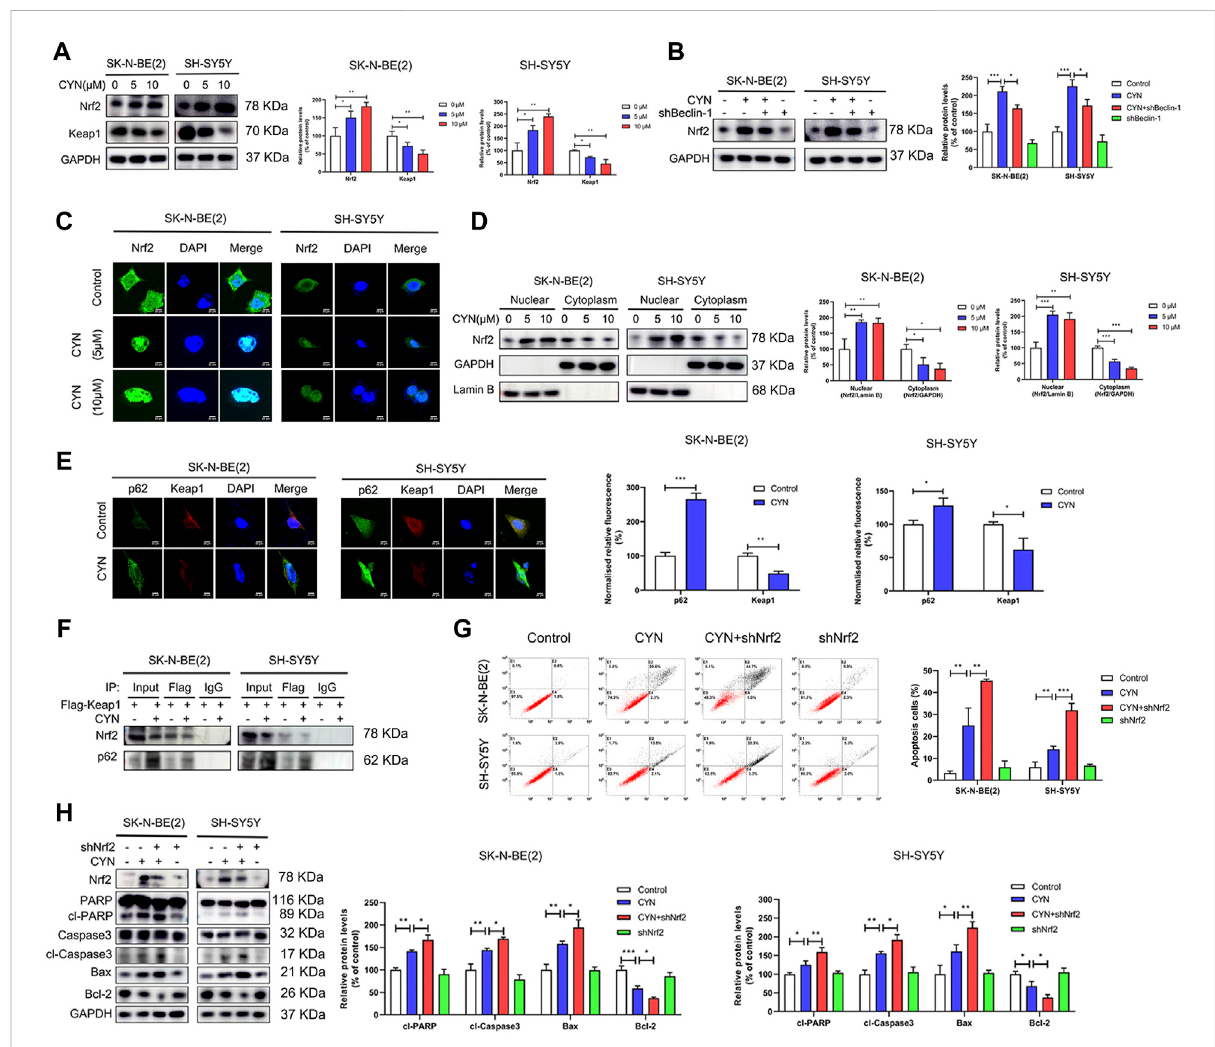
FIGURE 6 Relationship between the p62-Keap1-Nrf2 pathway and apoptosis in NB cells treated by CYN. (A) The Nrf2 and Keap1 protein level were determined by western blot. (B) Level of Nrf2 was analyzed by western blot. (C) CYN-treated NB cells were immunostained with anti-Nrf2 antibody (green) and counterstained with DAPI (blue). Scale bar: 20 µm. (D) The cytosolic and nuclear expressions of Nrf2 were determined by western blotting. (E) Immuno fl uorescence images and quantitative analysis of p62 and Keap1. Scale bars: 20 μ m. (F) Nrf2 and p62 were detected by western blot after IP with anti-Flag. (G) Apoptosis of NB cells was measured and analyzed by fl ow cytometry. (H) Western blotting analysis detected the expression of apoptosis-related proteins. * p < 0.05, ** p < 0.01, *** p < 0.001 versus the control group. * p < 0.05, ** p < 0.01, *** p < 0.001 versus the CYN